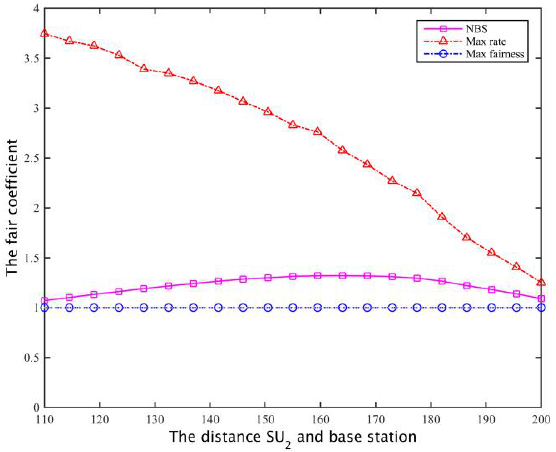
Figure 24. The comparison of fairness I.